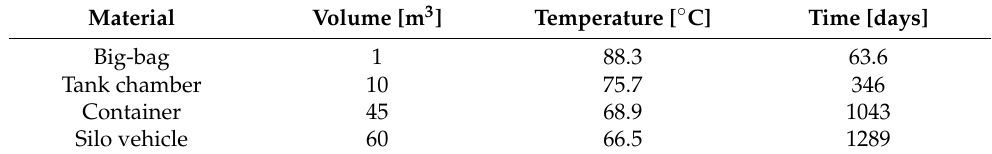
Table 9. The critical values of time and temperature for storage and transport of the sludge dust.